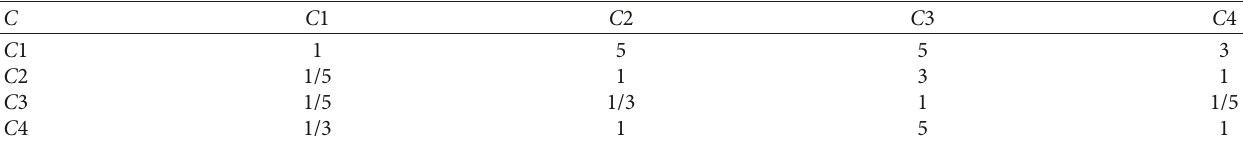
Table 4: Judgment matrix of C 1 i .